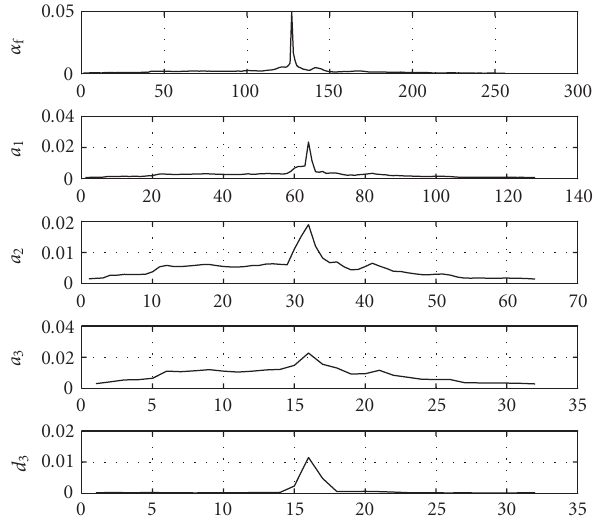
Figure 8: The part of the tree of variances of α r [ n ], as defined in the scheme. The figure starts with the original signal. The second plot is h , the third is hh , the fourth is hhh , and the last one is hhg .